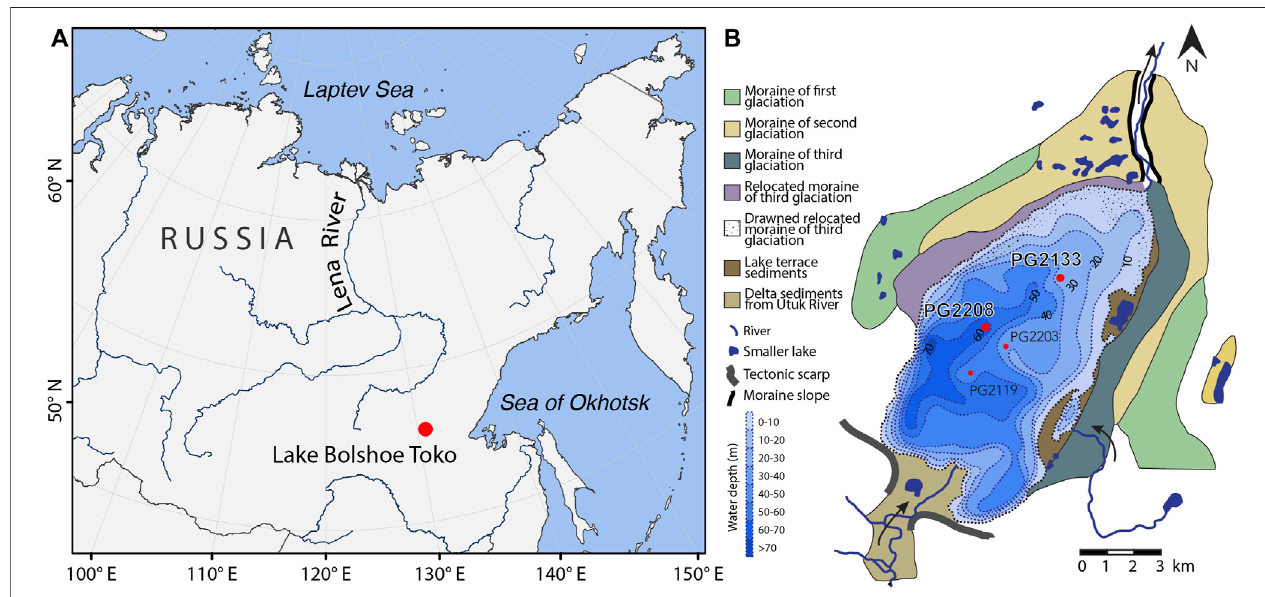
FIGURE 1 | Study site of Lake Bolshoe Toko. (A) Overview map. (B) Lake Bolshoe Toko with coring sites. Water depth isobaths based on Konstantinov (2000) slightly modi fi ed from Biskaborn B. K. et al. (2019). Moraine cartography and topographic features based on Kornilov (1962).